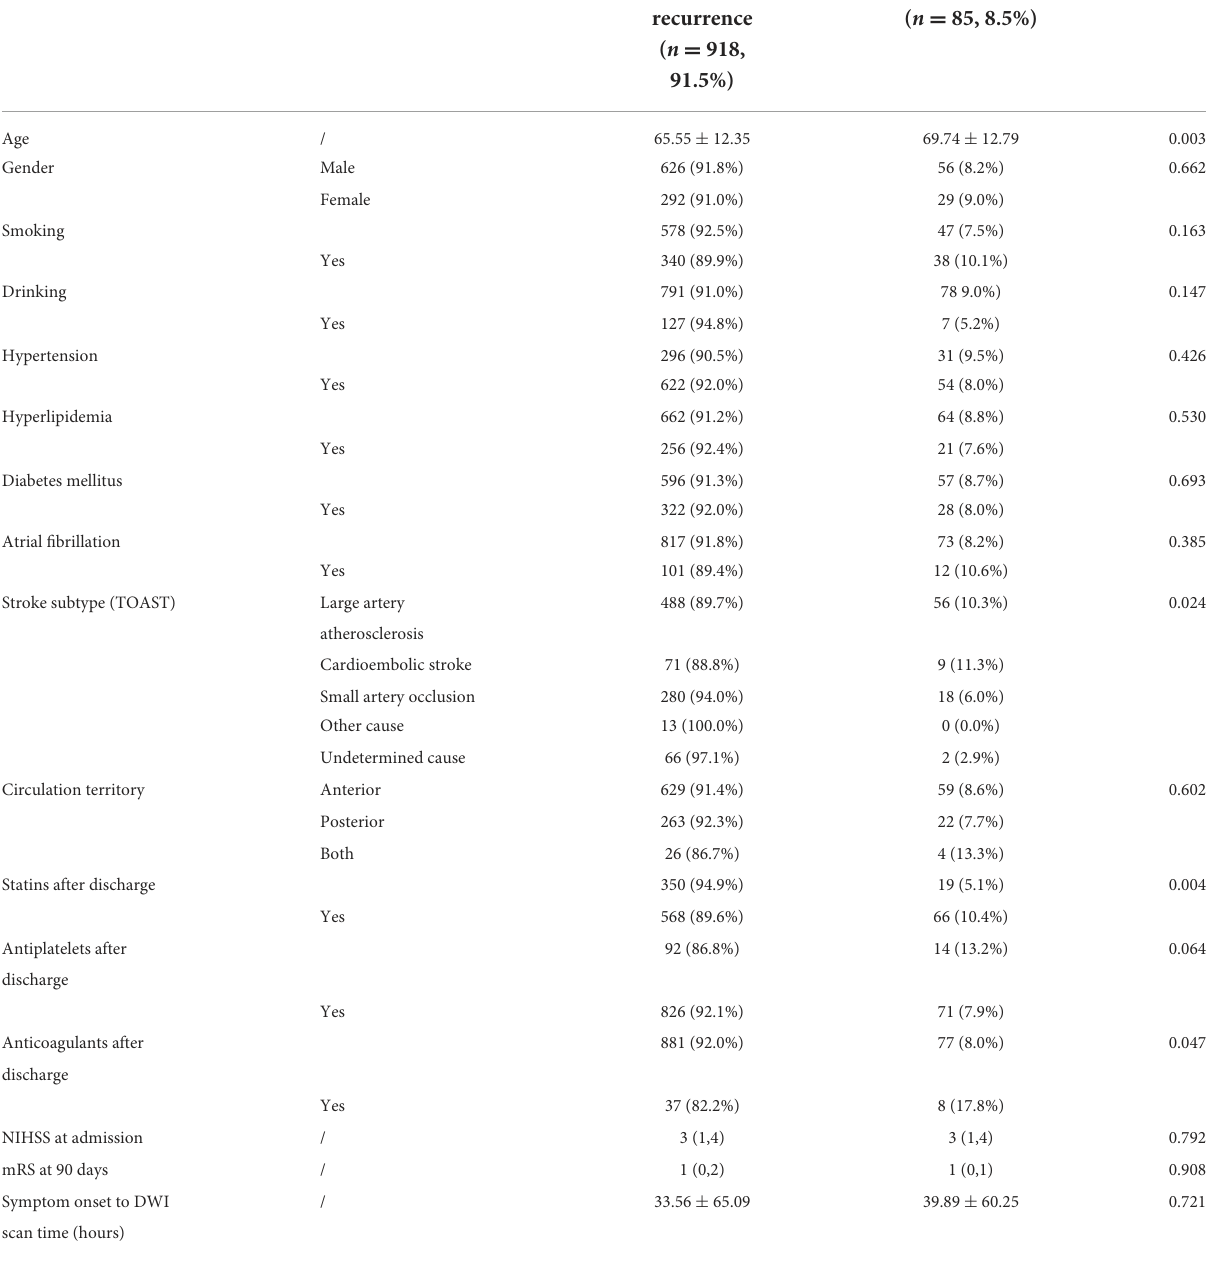
TABLE 1 Demographic and clinical characteristics in acute ischemic stroke